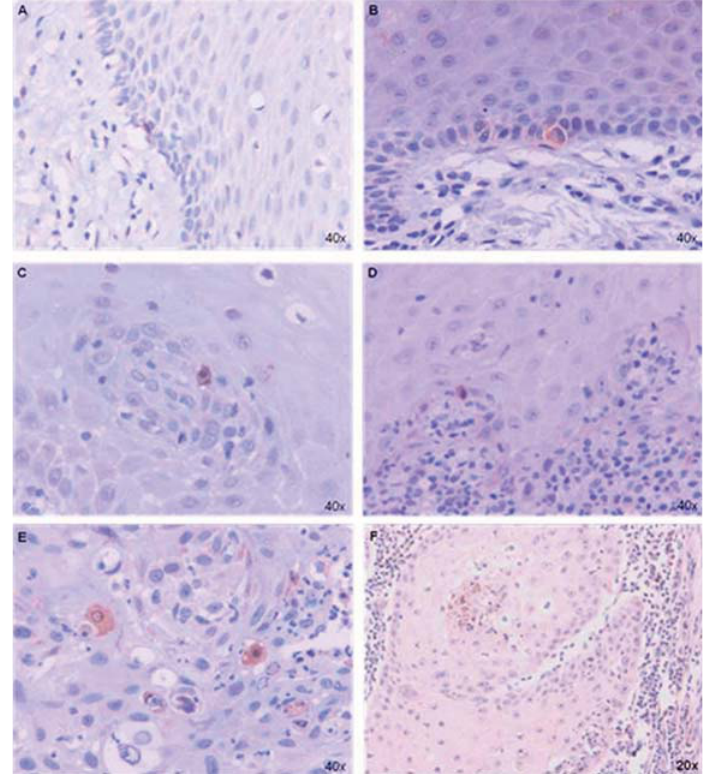
Figure 1- Immunohistochemical expression of cleaved caspase-3 in lesions. A- Intraoral oral leukoplasia (IFH). B- Lower lip IFH. C- oral leukoplasia (OL). D- actinic cheilitis (AC). E- Intraoral squamous cell carcinoma (SCC). F- Lower lip